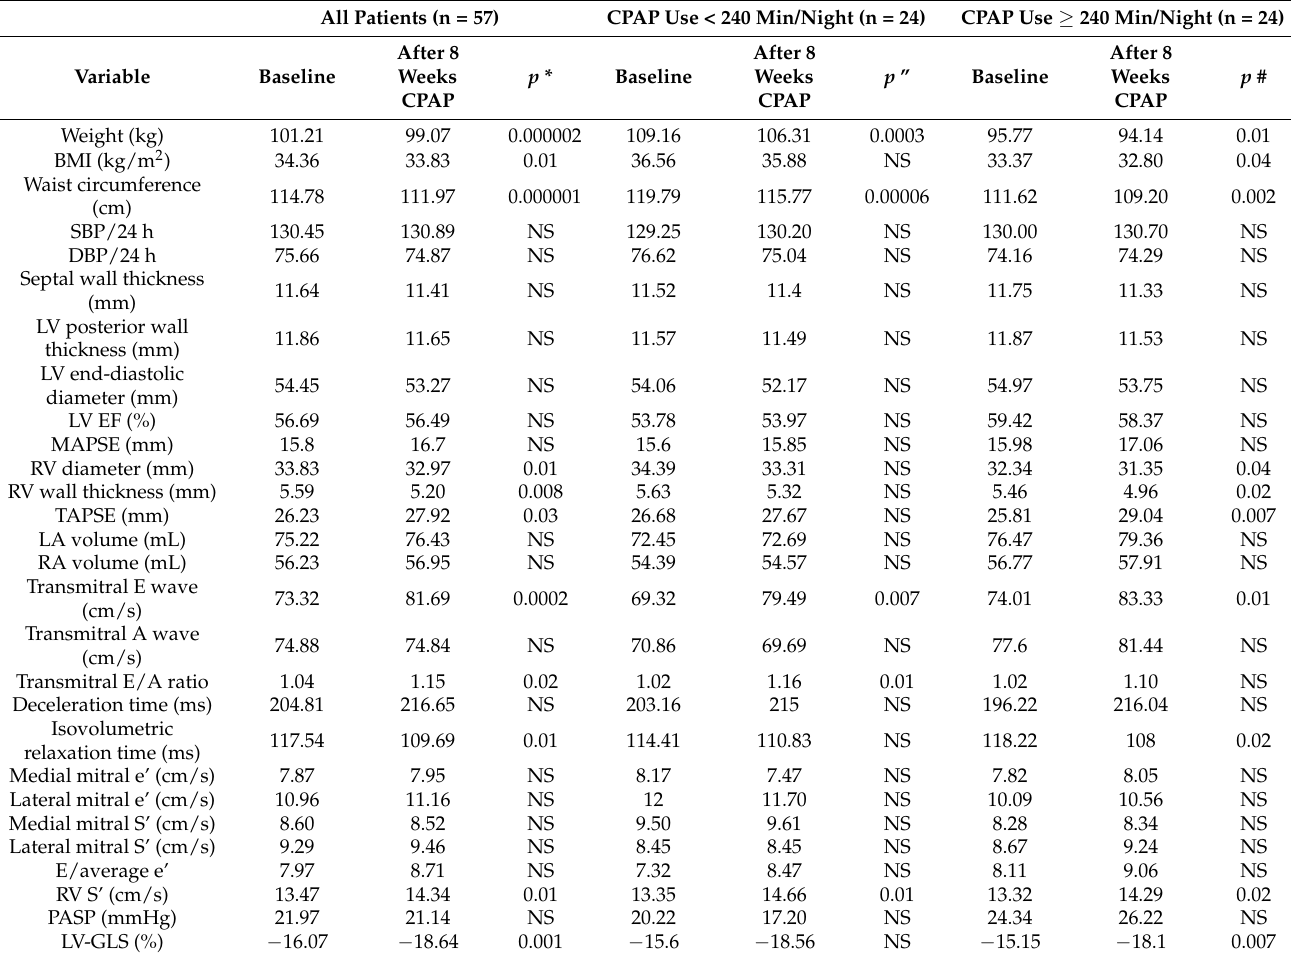
Table 3. Comparison of clinical and echocardiographic parameters in our study group, before and after 8 weeks of CPAP. All Patients (n = 57) CPAP Use < 240 Min/Night (n = 24) CPAP Use ≥ 240 Min/Night (n = 24)